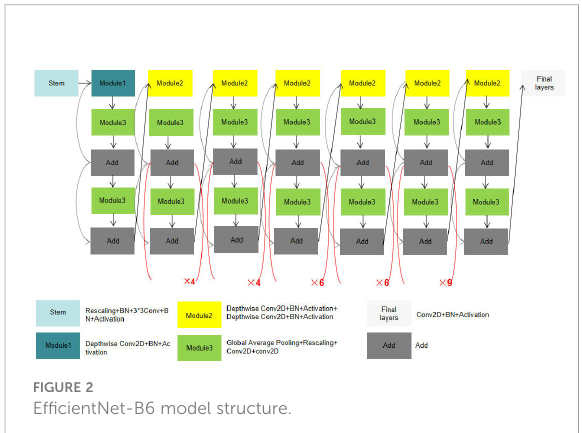
FIGURE 2 Ef fi cientNet-B6 model structure.